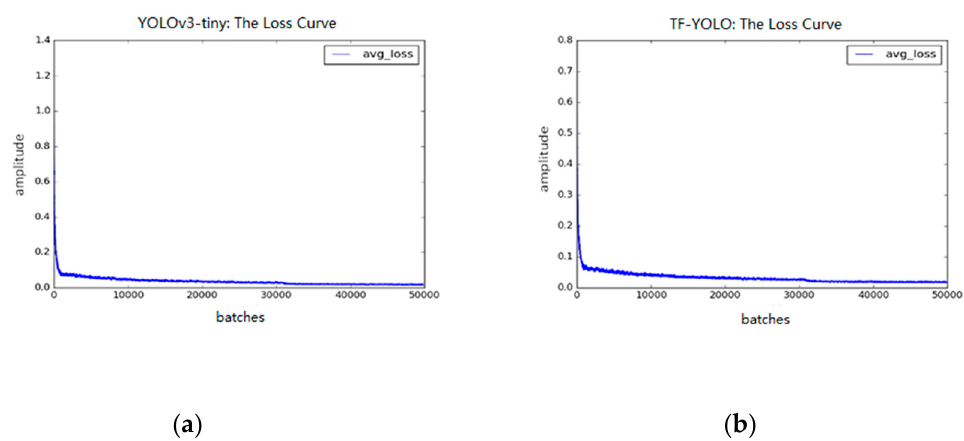
Figure 6. The comparison of loss curves for two networks: ( a ) YOLOv3-tiny network; ( b ) TF-YOLO Figure 6. Thecomparison ofloss curvesfortwo networks: ( a )YOLOv3-tiny network; ( b )TF-YOLO network.